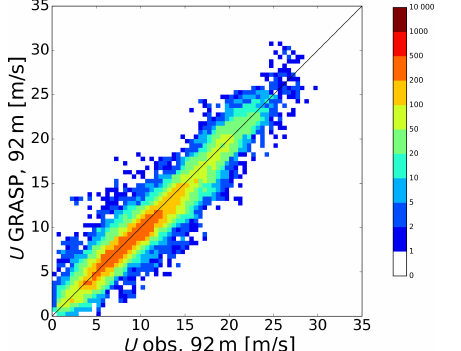
Figure 4. Scatter–density plot of modelled versus observed 92m wind